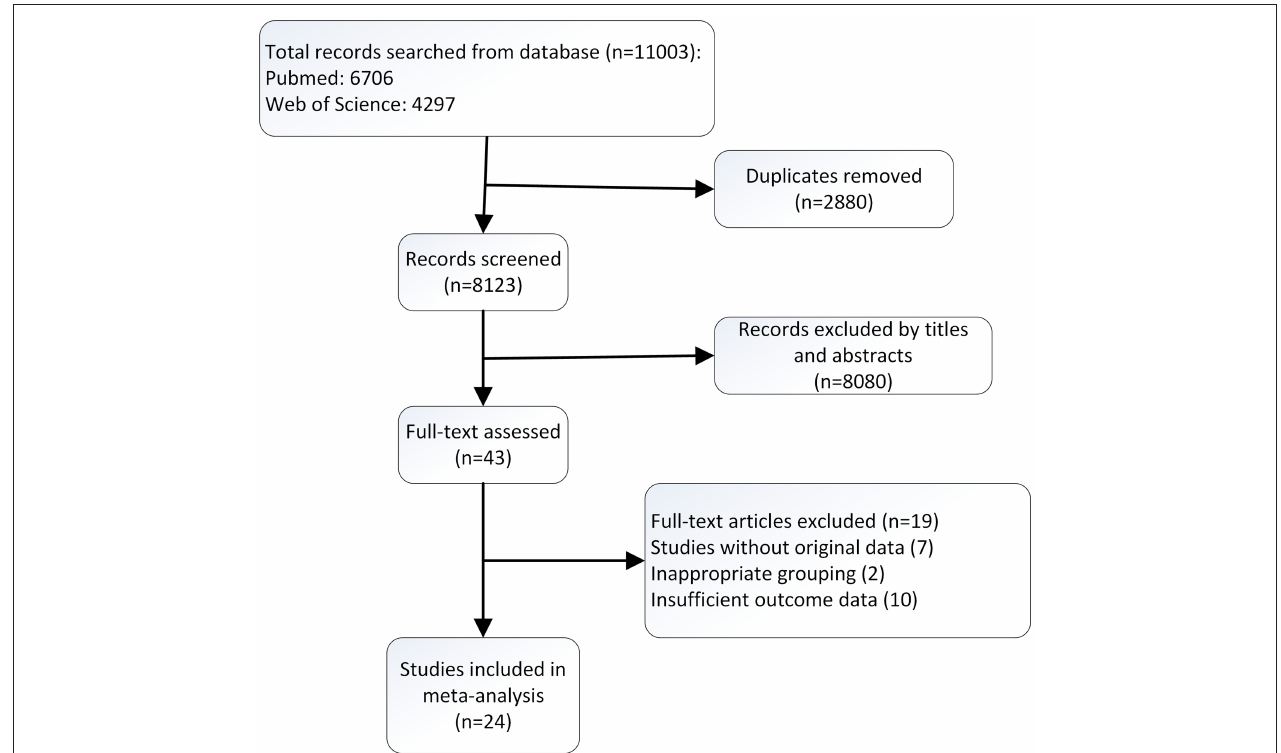
FIGURE 1 | Flow diagram of reference selection